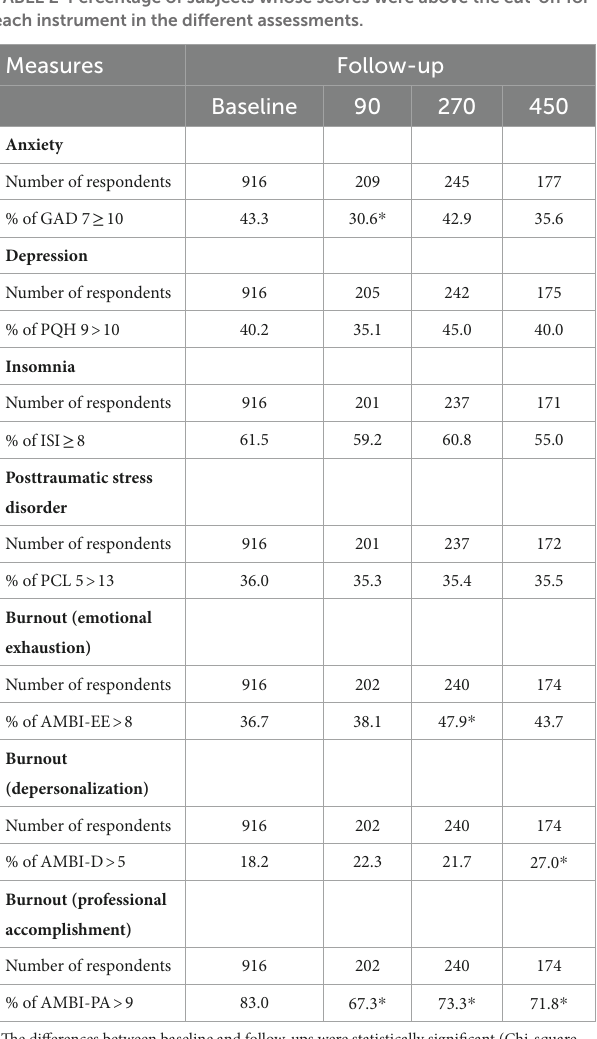
were above the recommended for each instrument were showed in Table 2. A decrease in anxiety levels was found in D90. This period coincides with a decline in new cases (end of the first wave), though